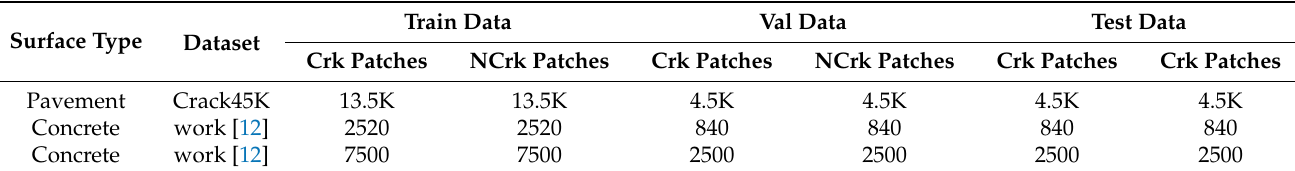
Table 1. Representation of images split in pavement and concrete datasets.